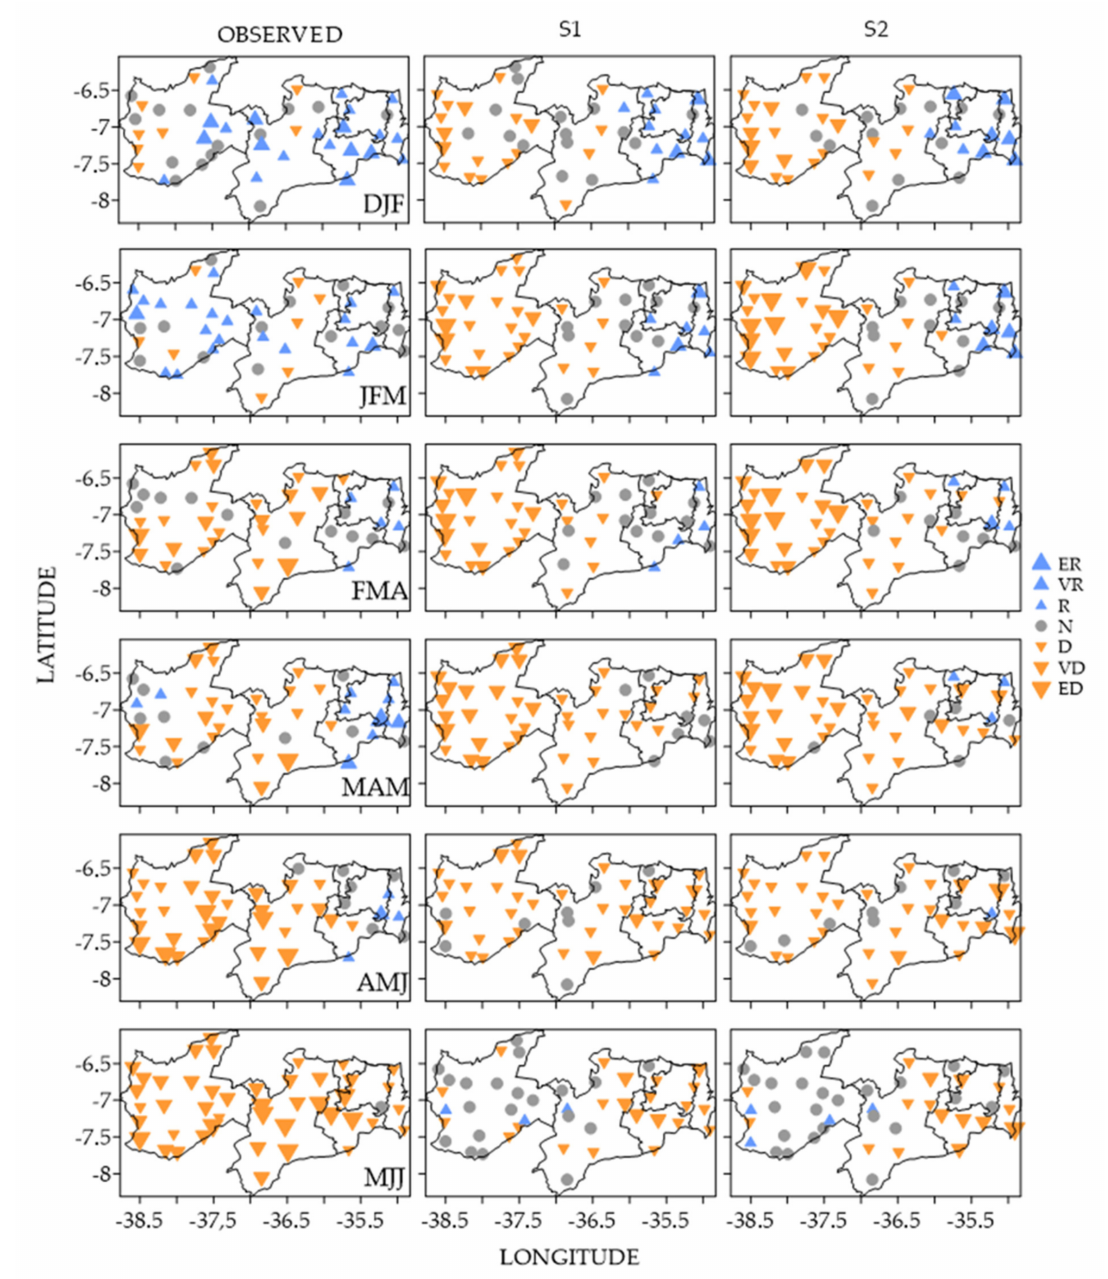
Figure 7. Quantiles of values observed and simulated by the GAMLSS model for S1 and S2 scenarios in Para í ba state for 2016 (Legend: ER = Extremely Rainy ( (cid:78) ), VR = Very Rainy ( (cid:78) ), R = Rainy ( (cid:78) ), N = Normal ( • ), D = Dry ( (cid:72) ), VD = Very Dry ( (cid:72) ) and, ED = Extremely Dry ( (cid:72)